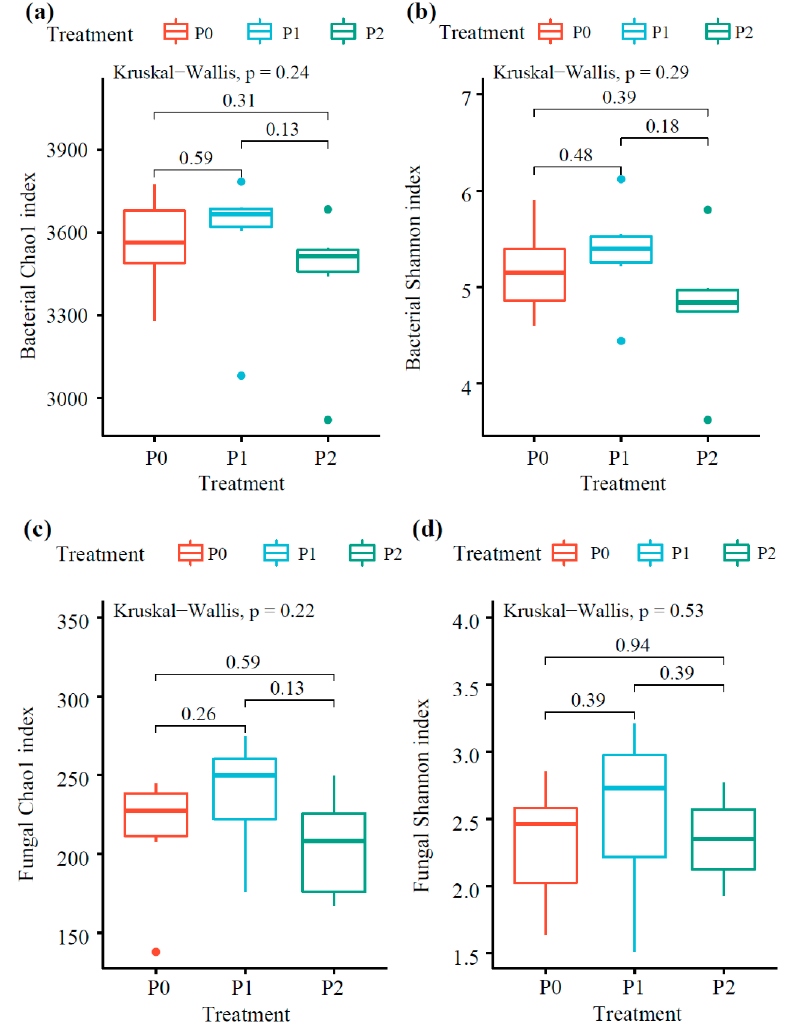
Figure 1. Rhizosphere microbial alpha diversity changes under different treatments. ( a ) bacterial Chao1 index, ( b ) bacterial Shannon index, ( c ) fungal Chao1 index, and ( d ) fungal Shannon index. Significant differences of soil microbial alpha diversity were tested by the Kruskal – Wallis test at p < 0.05.